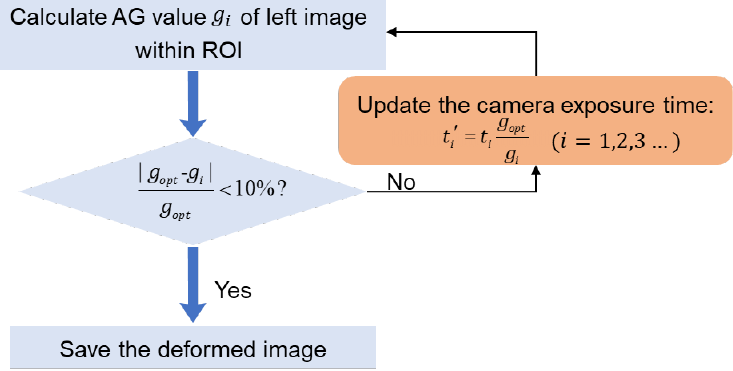
Figure 3. The implementation flow chart of optimal exposure time determination for deformed image pair acquisition.